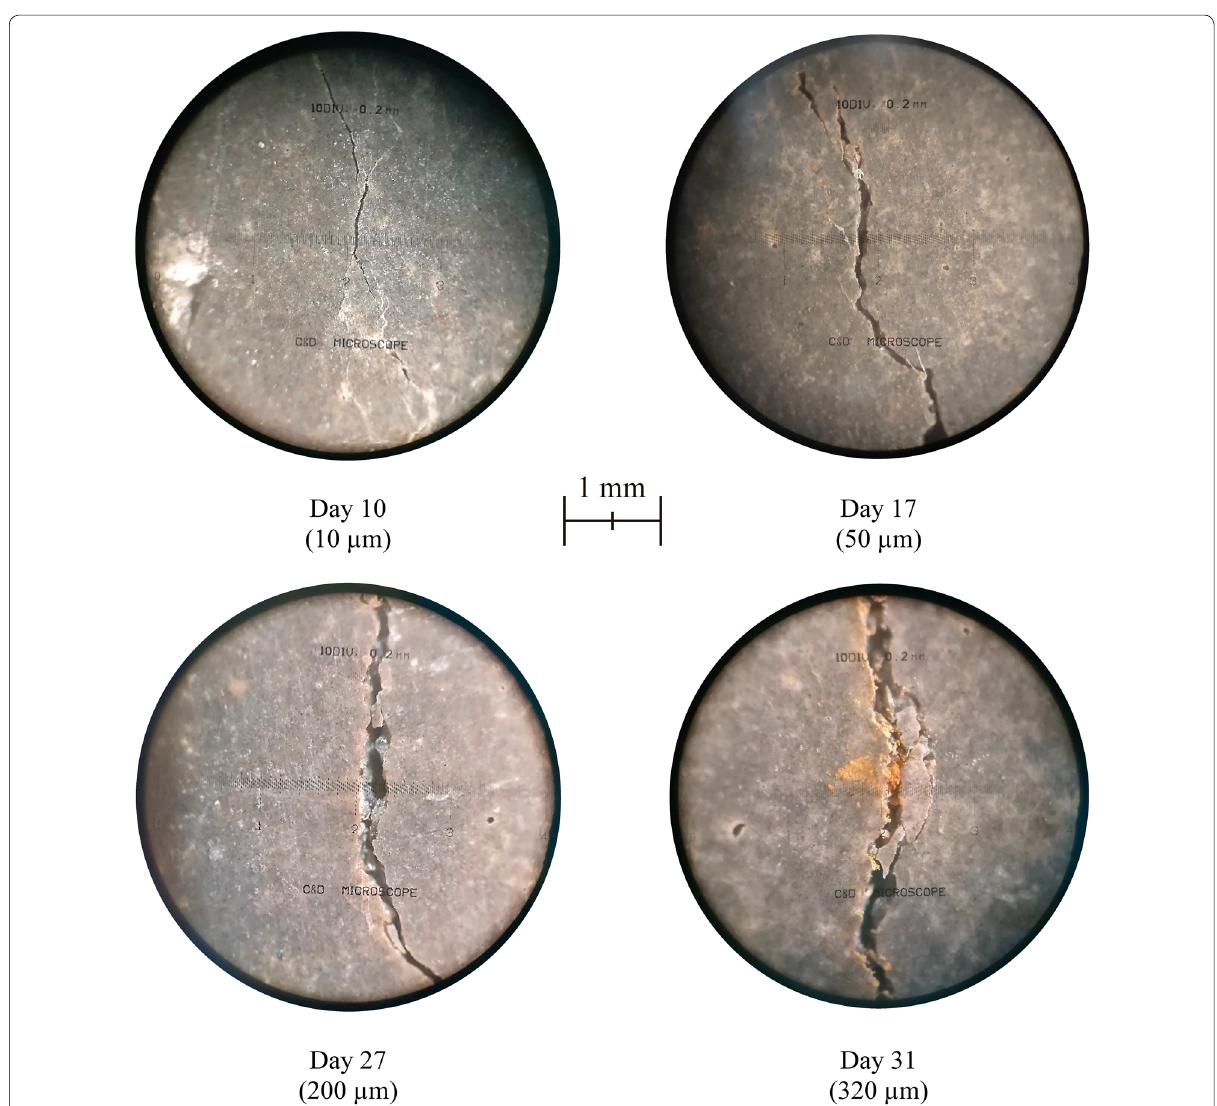
Fig. 8 Images corresponding to the evolution of the maximum size of the crack on top of the mortar specimen number